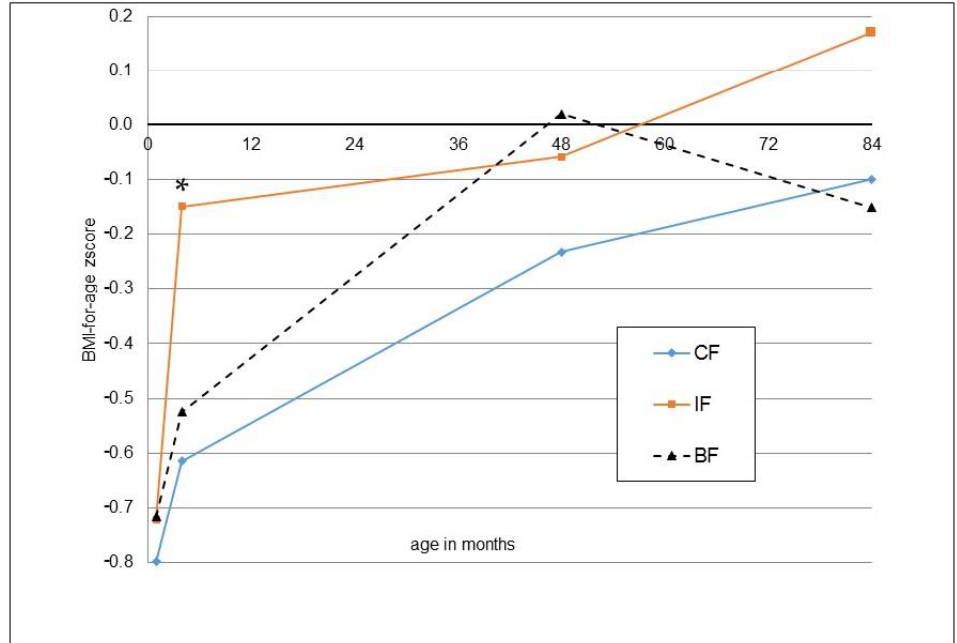
Figure 4. Mean z-scores for BMI-for-age at one month (IF: n = 50, CF: n = 54, BF: n = 57), four months ( n = 50, 5 n = 4, n = 57), four years ( n = 48, n = 52, n = 57) and seven years ( n = 50, n = 54, n = 57) for those children participating in the 7-year follow-up; * significant difference between IF and CF, t -test. Table 3. Growth per day (mean ± SD) during the first seven years of life for the interventional formula group (IF), control formula group (CF) and formerly breastfed infants